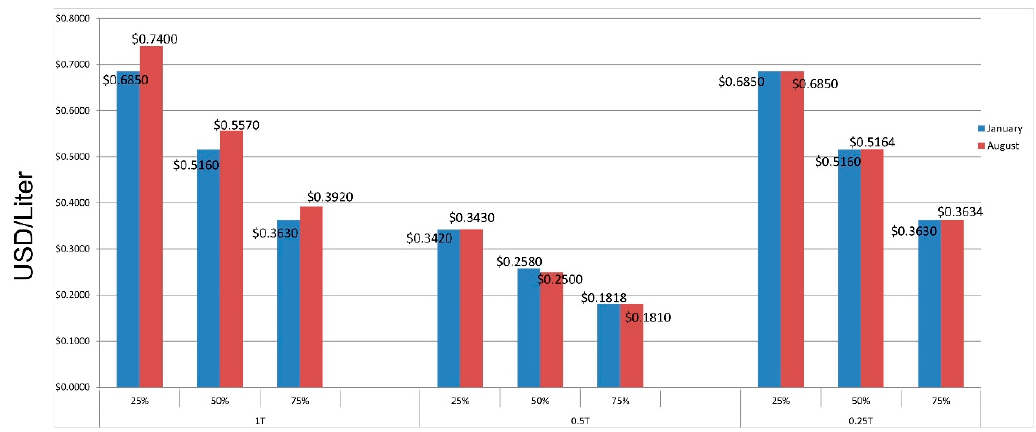
Figure 10. Cost per litre of water produced by the atmospheric water generator.